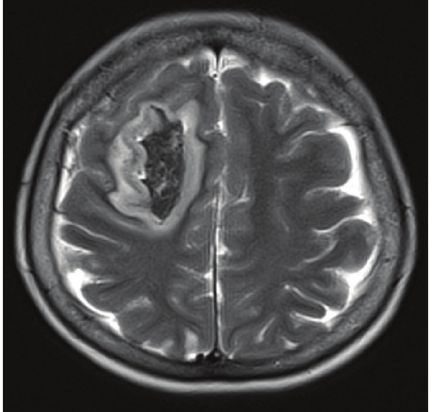
Figure 2: Compromised arterial wall by an inflammatory infiltrate of lymphocytes and multinucleated giant cells. (H & E 10X.)